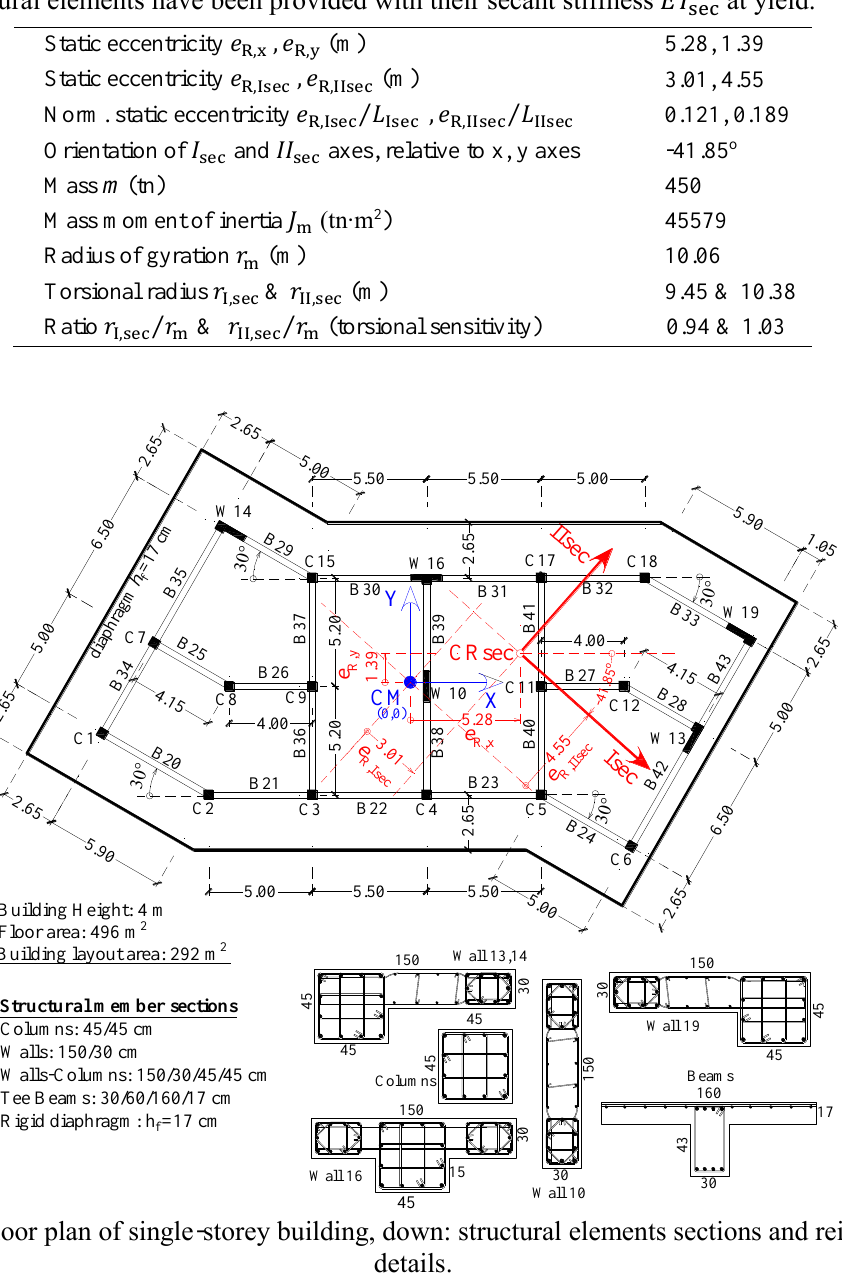
Elastic, inertial characteristics and torsional sensitivity control of the non-linear model of the building, in which all structural elements have been provided with their secant stiffness 𝛦𝐼